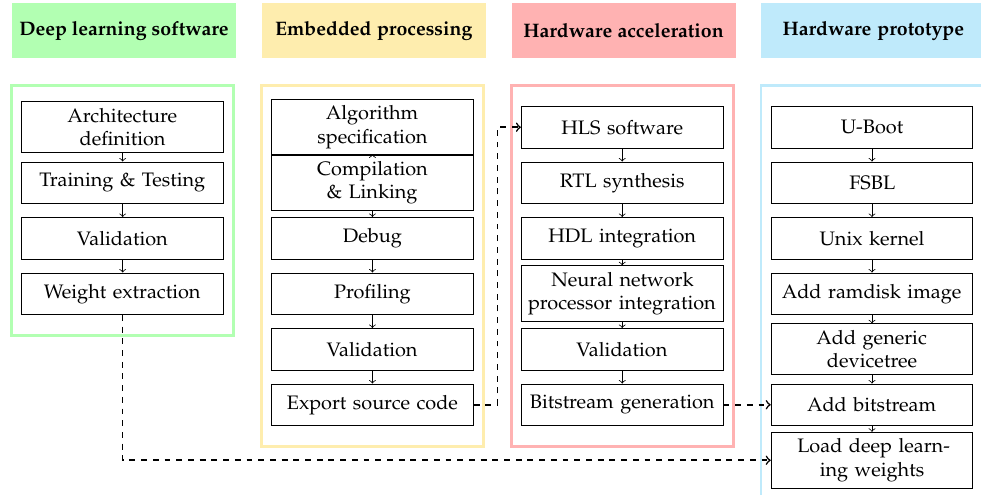
Figure 2. Design flow for the embedded DL methodology.